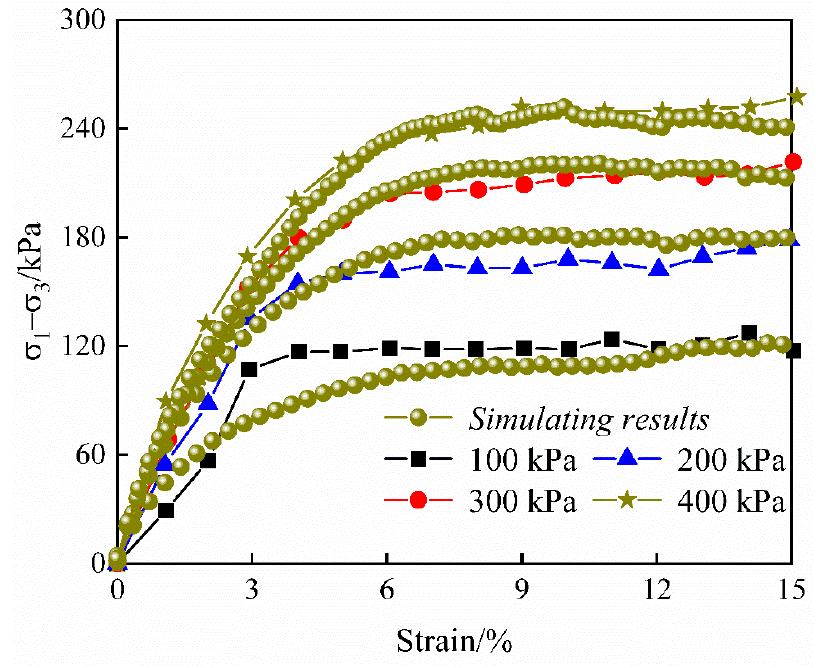
Figure 5. Stress–strain curves of undisturbed soil in DEM.